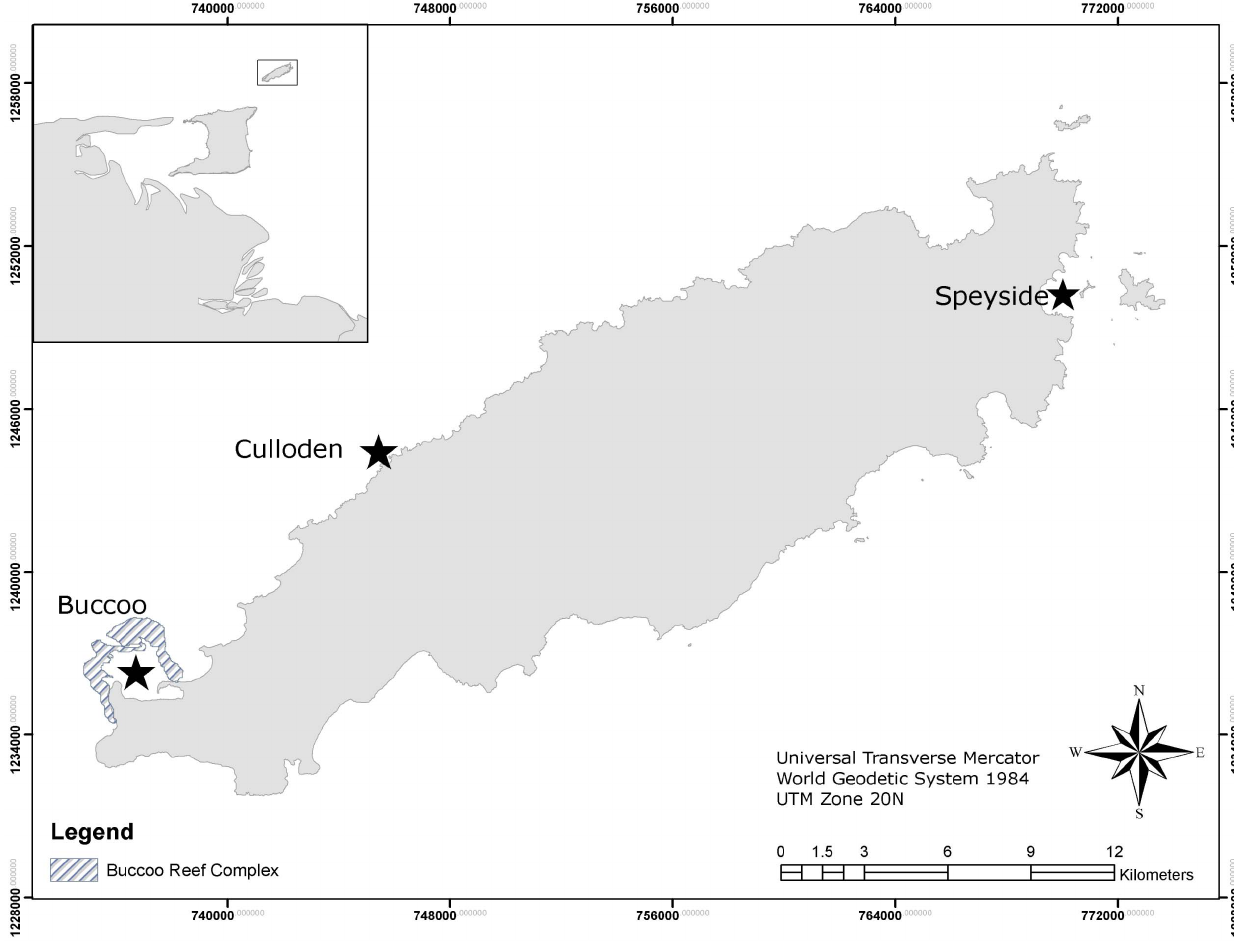
Figure 1. Map of Tobago showing the locations of sampling sites (black stars) with inset of Trinidad and Tobago.